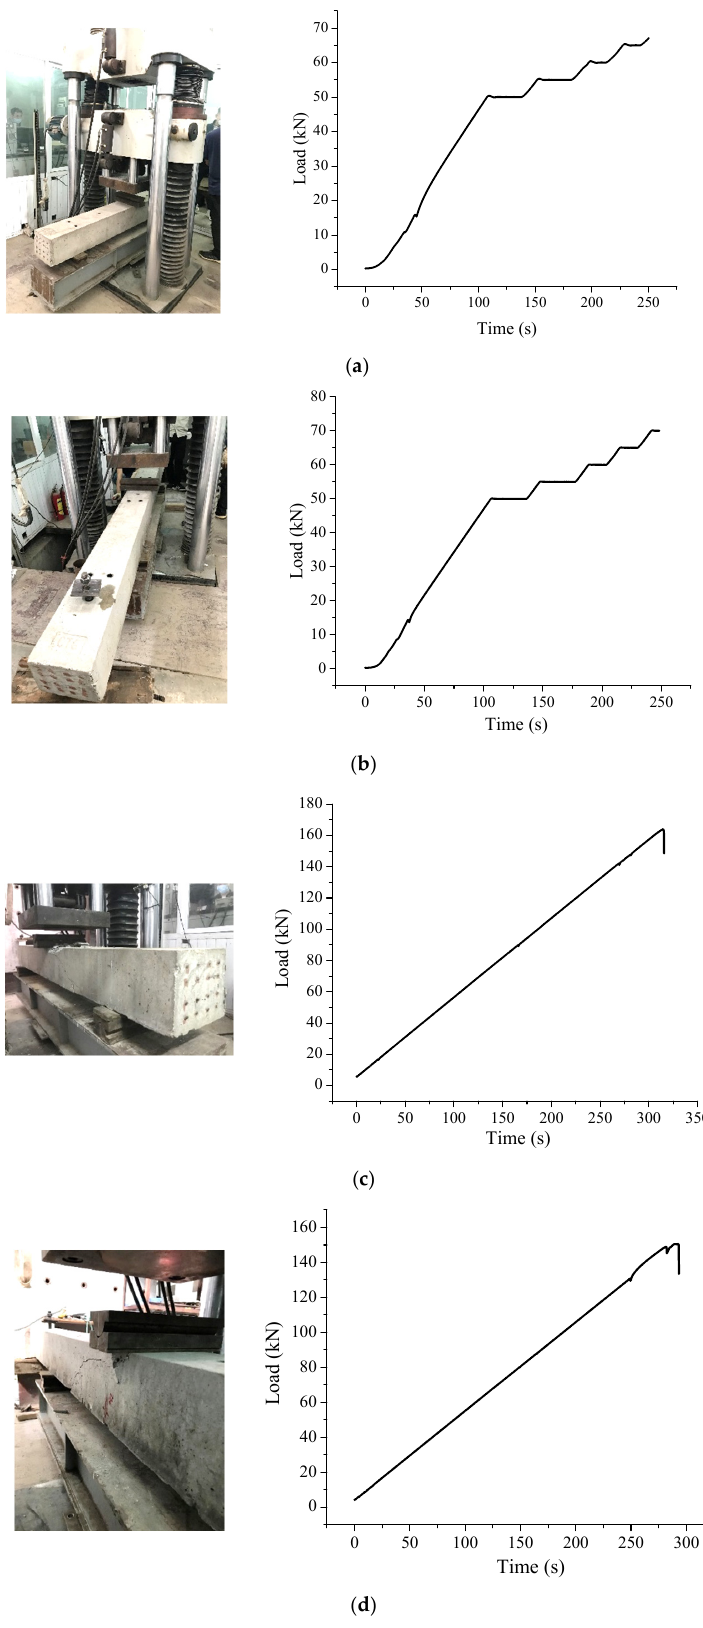
Figure 13. Results of positive bending moment test. ( a ) Test load for first crack (PSB1); ( b ) Test load